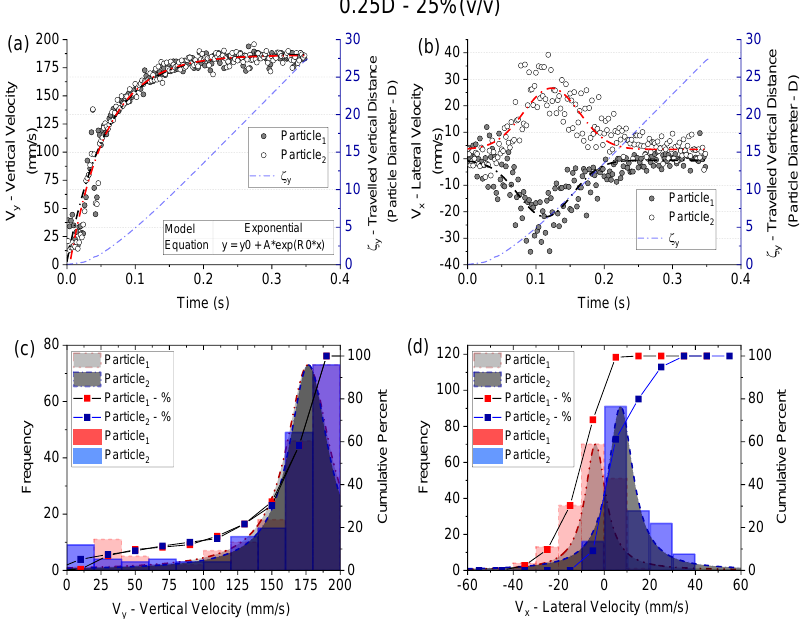
(cid:17) ∆ (cid:16) δ x δ 0 ∆(cid:4672) (cid:3331)(cid:3299) (cid:3331)(cid:3116) (cid:4673) ∆ t ∆(cid:3047)